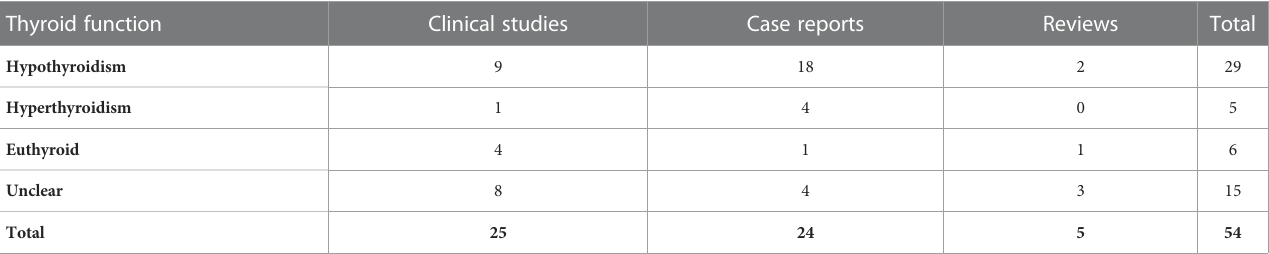
TABLE 1 Study characteristics.